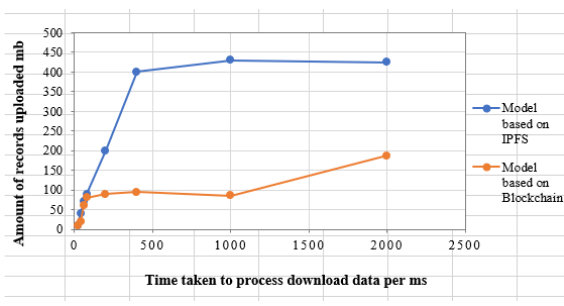
Fig. 5.2. Comparison of upload transactions between IPFS and Blockchain